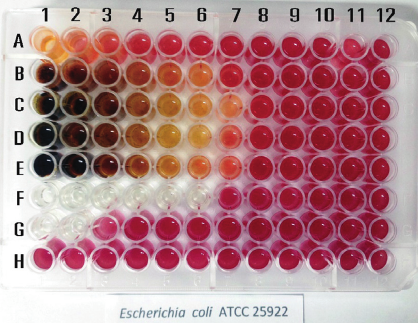
Figure 3: Minimum inhibitory concentration (MIC) sensitivity testing was a microdilution assay using flat shape 96-well plate. This is an example of crude metabolite extract P. retrofractum Vahl against E. coli ATCC25922. The MIC was read after tetrazolium was added which has shown the lowest concentration of antimicrobial agent at which it was colorless or changed to pale pink. The wells F1 to F6 were negative control, and the wells F7 to F12 were positive